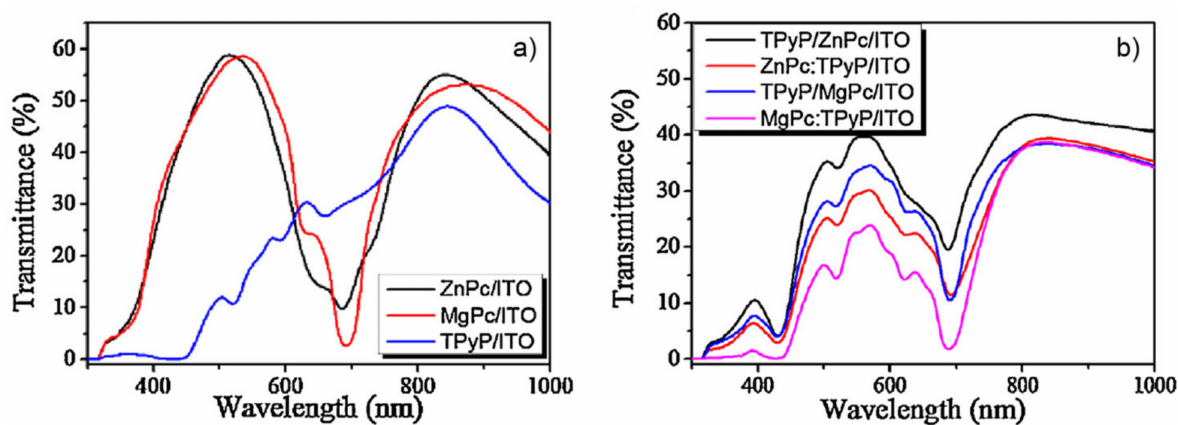
Figure 2. UV–Vis spectra of ( a ) single films and ( b ) stacked and BHJ films based on ZnPc, MgPc and TPyP obtained on ITO substrate. Reprinted with permission from [40]. Copyright 2016